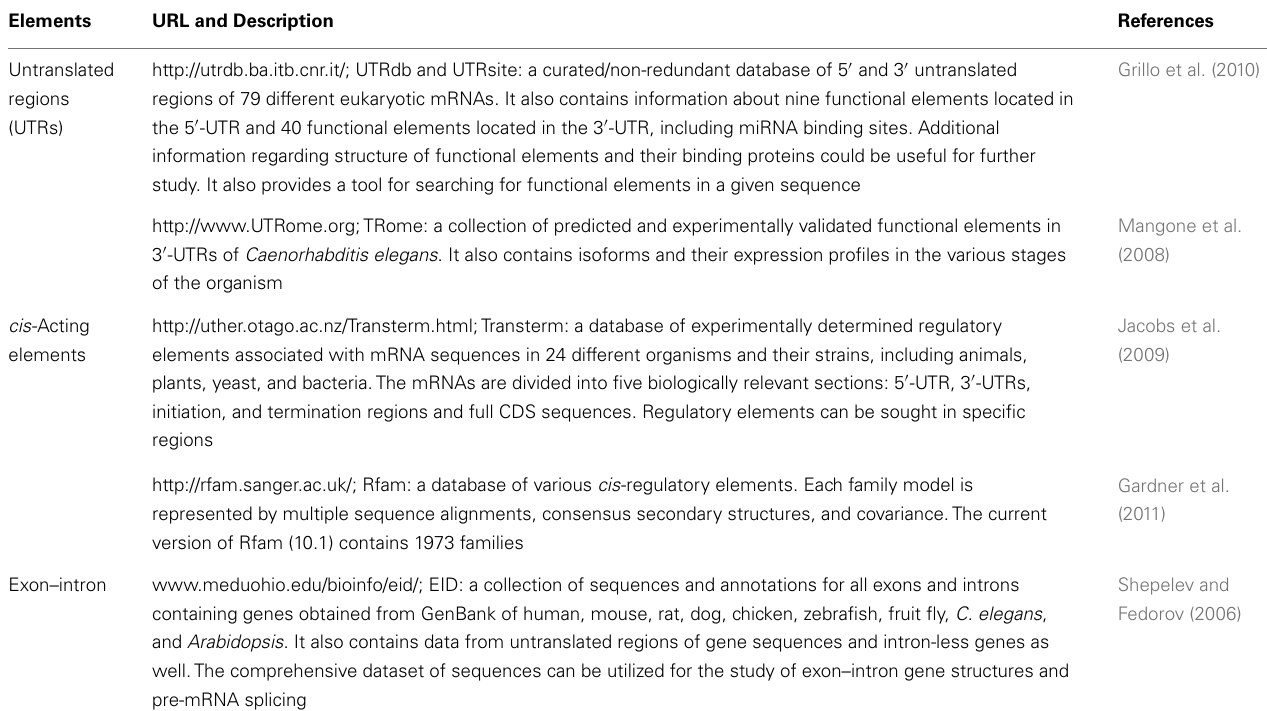
Table 1 | Databases of different functional elements of mRNA and their